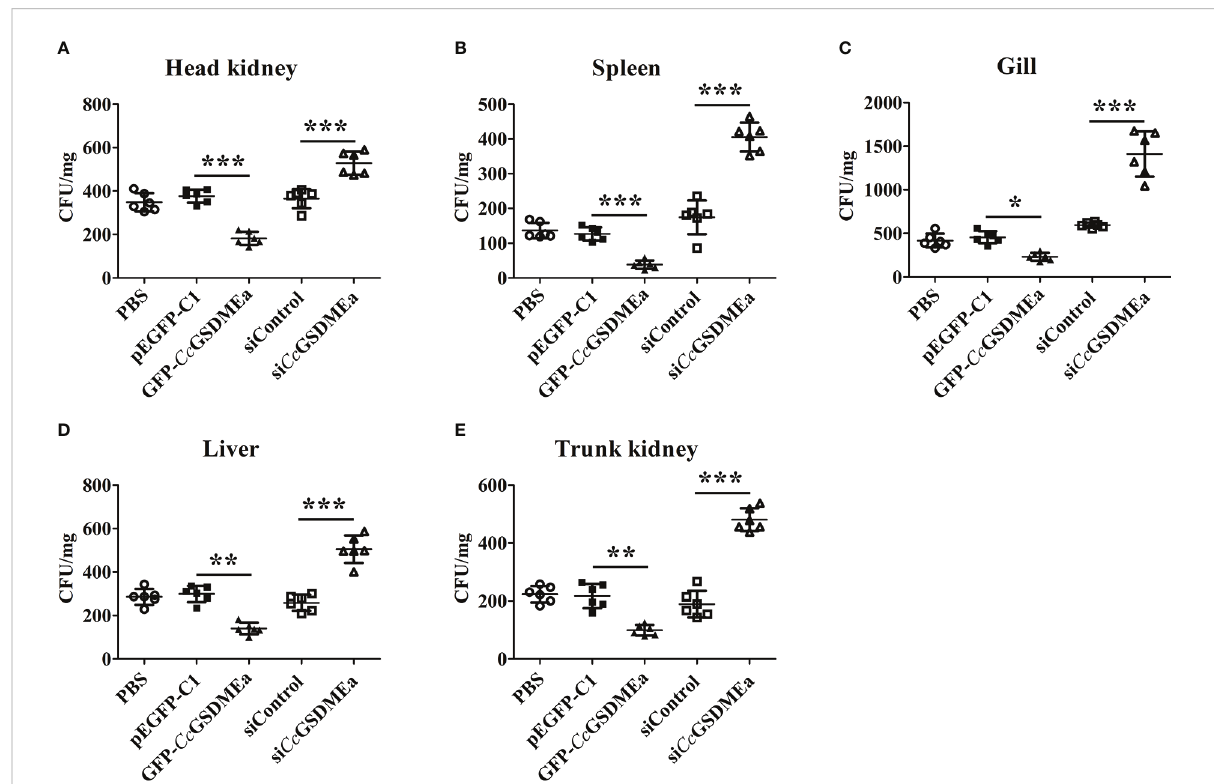
FIGURE 8 Cc GSDMEa prevents A. hydrophila colonization in vivo . Bacterial burdens in head kidney (A) , spleen (B) , gill (C) , liver (D) and trunk kidney (E) of different groups infected with A. hydrophila . The data are expressed as mean ± SD (n = 3) and analyzed statistically by student ’ s t test ( * , P < 0.05; ** , P < 0.01; *** , P <